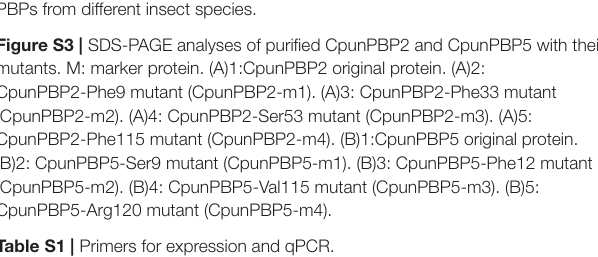
Table S1 | Primers for expression and qPCR. Table S2 | Primers for mutants of CpunPBP2 and